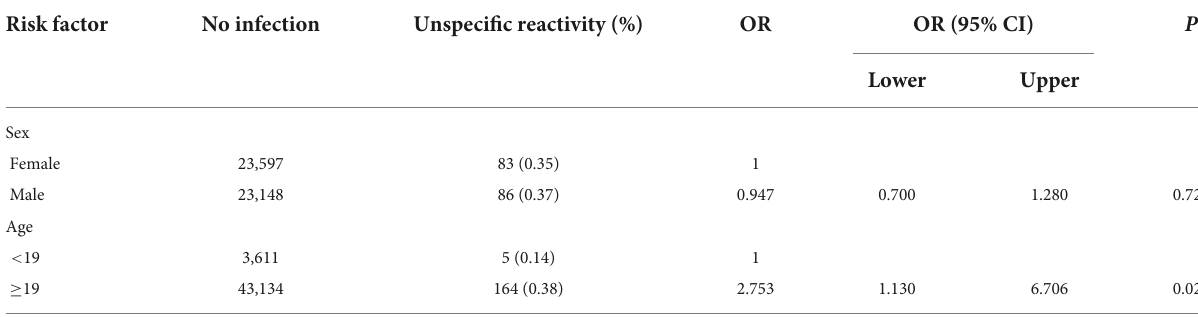
TABLE 2 Disease spectrum associated with unspecific reactivity according to the International Classification of Diseases, Revision 10.